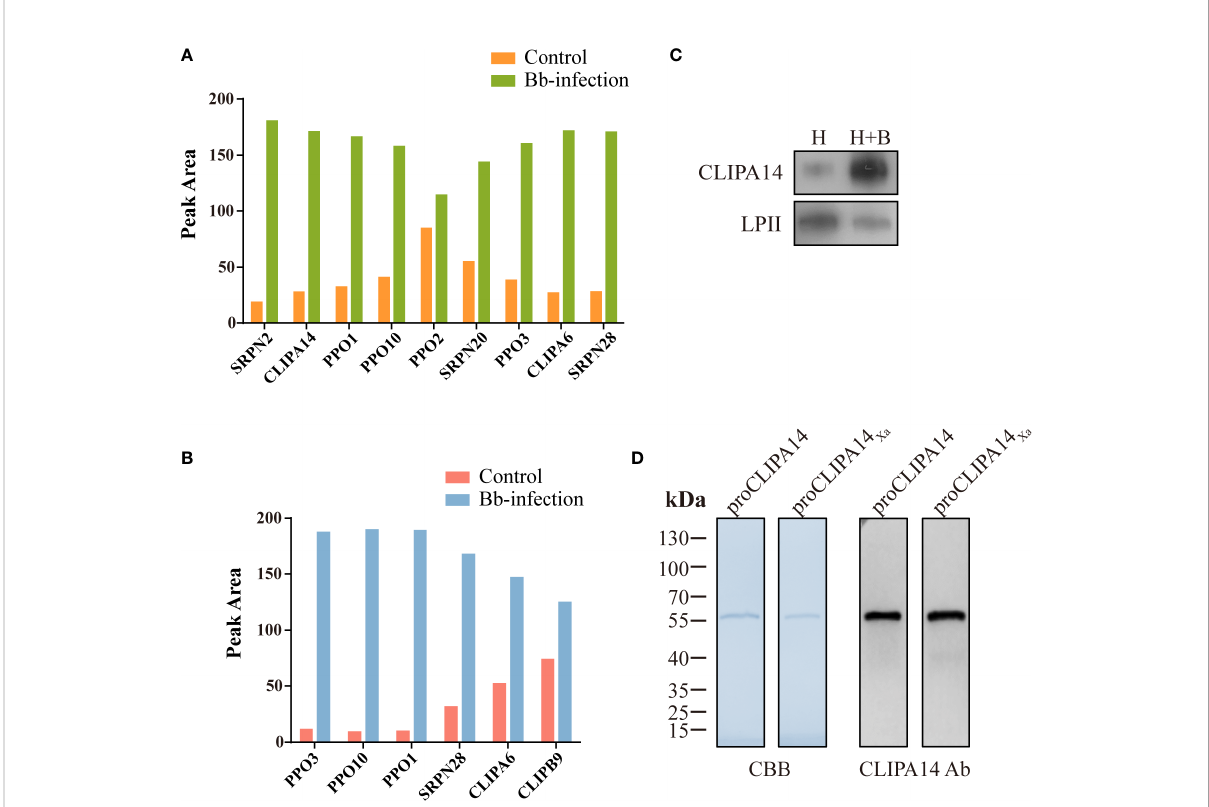
FIGURE 4 A potential interacting protein of CLIPB9. Proteomic analysis of CLIPB9 (A) and CLIPA14 (B) associated proteins. Co-IP experiments were performed on Bb-infected and control cell-free hemolymph using anti-CLIPB9 or anti-CLIPA14 antibody. Proteins eluted from the immunoaf fi nity columns were treated with trypsin for LC-MS/MS analysis. Peak processing was performed using Proteome Discoverer 2.4.1.15 (Thermo Fisher Scienti fi c) software. (C) Immunoblotting analysis of CLIPA14 expression in hemolymph after B. bassiana infection. H, mosquito hemolymph was uninfected. H + B, mosquito hemolymph infected with B. bassiana . Anti-LPII antibody was used as the loading control. (D) Puri fi ed recombinant proCLIPA14 and proCLIPA14 Xa analyzed by SDS-PAGE and immunoblotting. Left, CBB staining. Right, immunoblotting using anti-CLIPA14